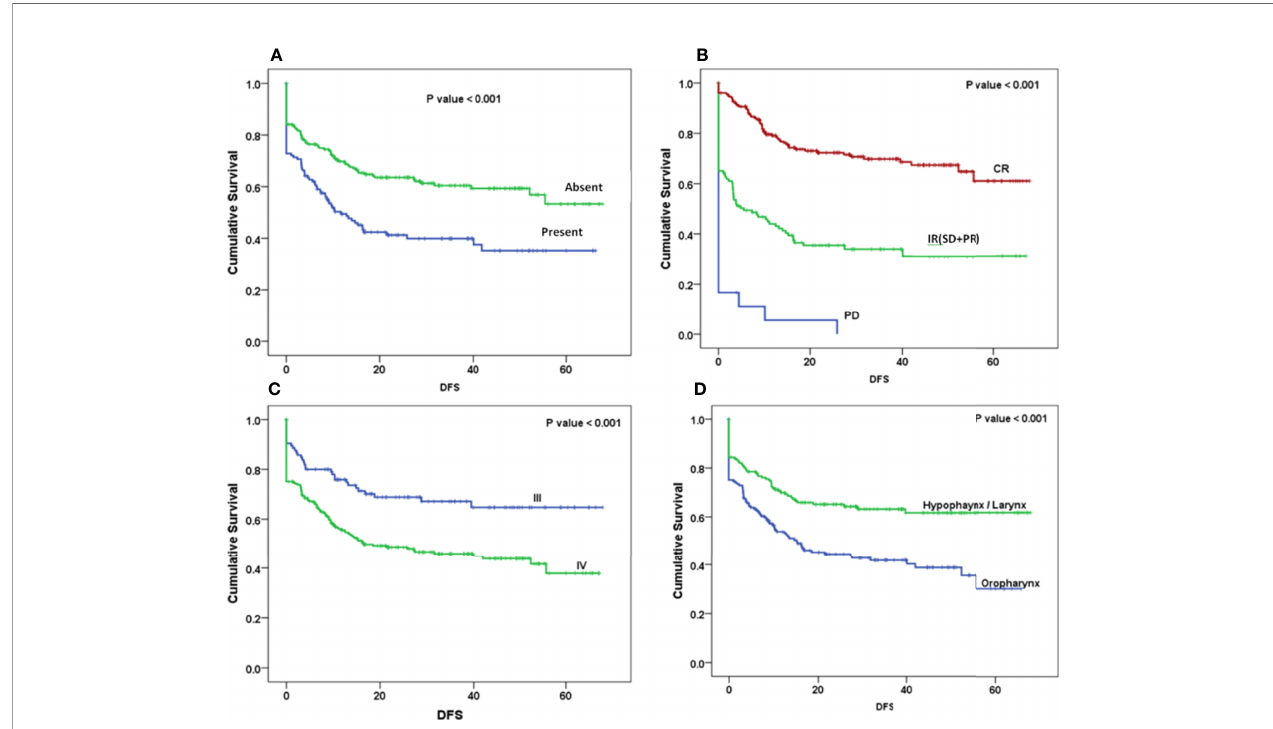
FIGURE 6 | Kaplan – Meier survival curves showing disease-free survival (DFS) by clinical factors: (A) rENE, (B) response, (C) , overall stage, and (D) site.